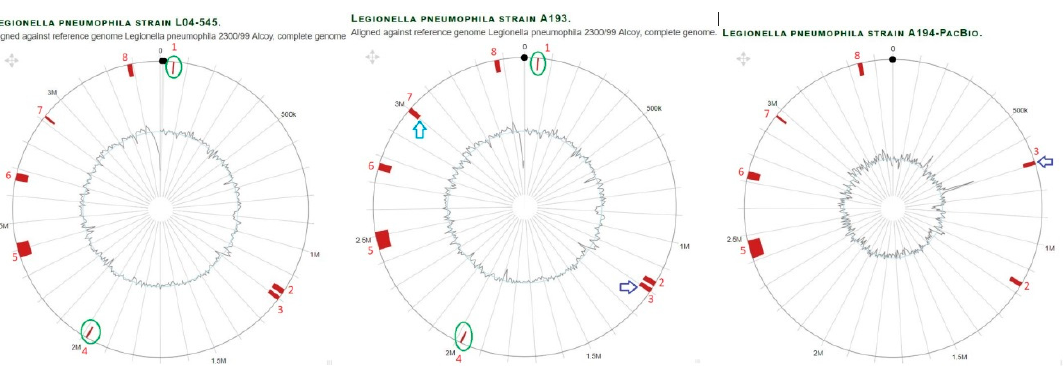
Figure 4. Comparison of genomic islands in branch Philadelphia of L. pneumophila strain A129 and A156 aligned against reference genome L. pneumophila strain Philadelphia1 . With regard to the outer layers, the circle shows: (i) nucleotide positions in Megabase pairs (Mbp) (black); (ii) Is- land-Viewer-annotated potential genomic islands (GI) are labeled accordingly (red); (iii) extra GIs (marked by green oval); (iv) GI with different sizes (blue arrow).